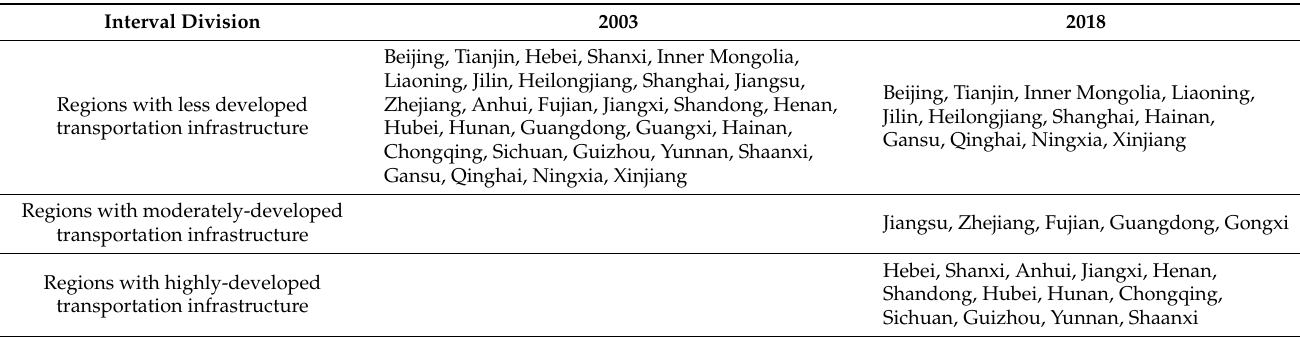
Table 8. Division of transportation